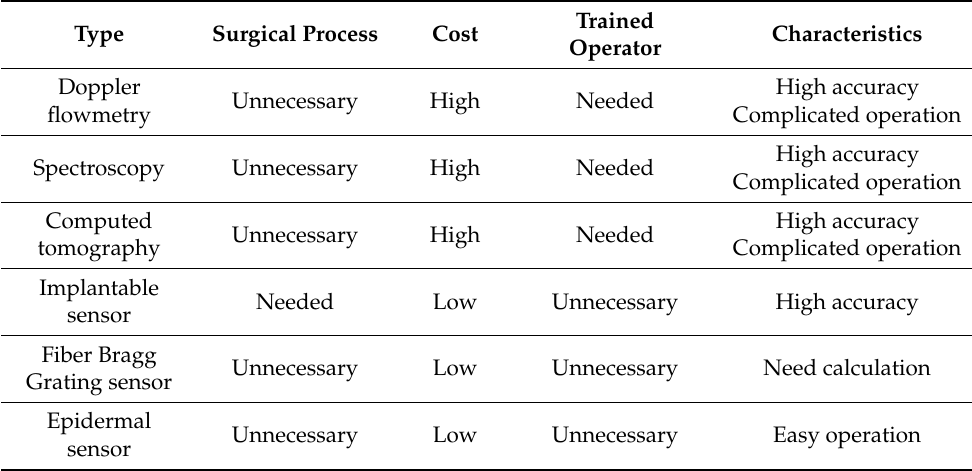
Table 1. Comparison of methods to monitor blood